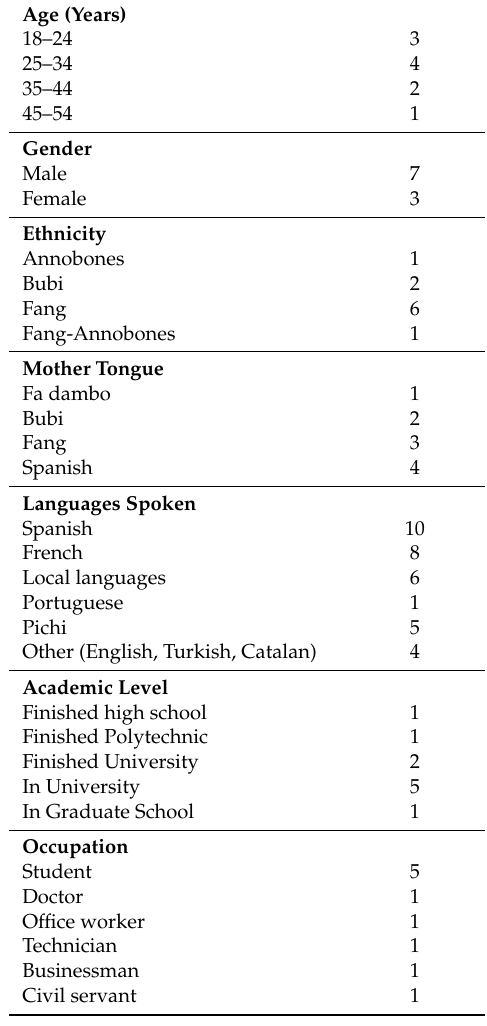
Table 2. Characteristics of Respondents ( n =